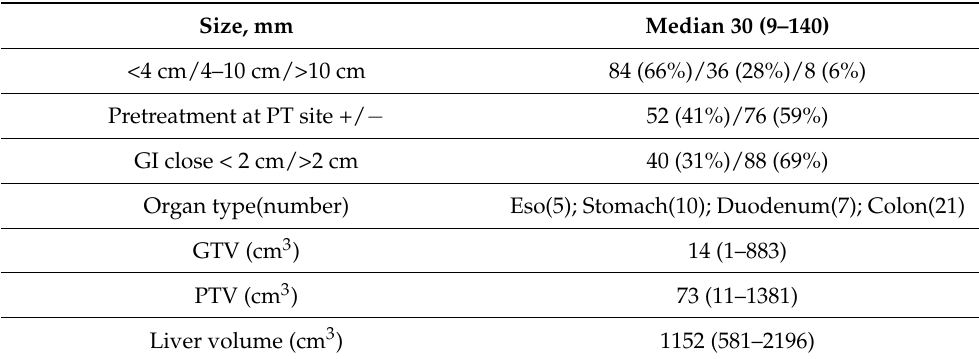
Table 2. Baseline tumor characteristics of 128 treated